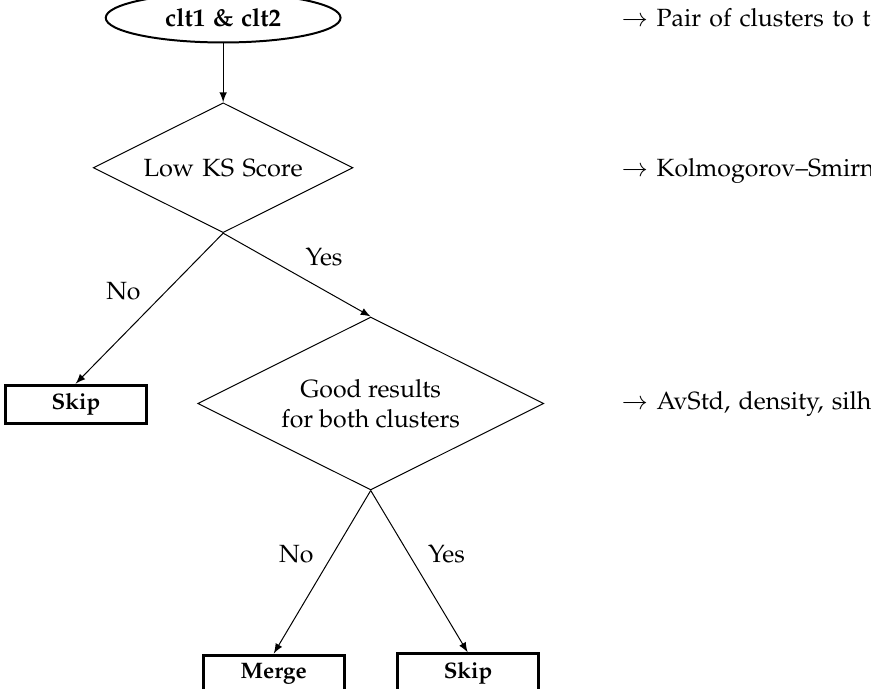
Figure 11. Summary of the fusion of the information brought by the quantifiers and the KS